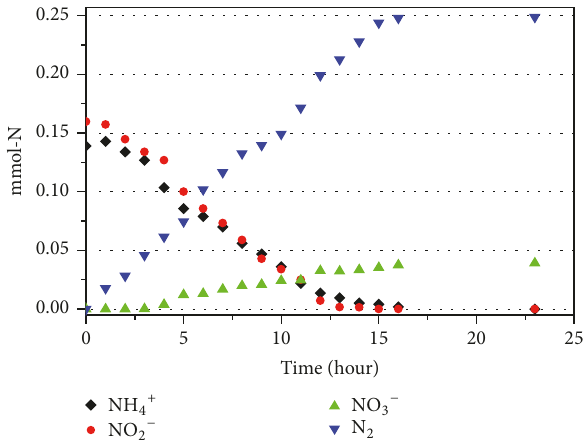
Figure 1: Initial N-removing performance of functional microbial